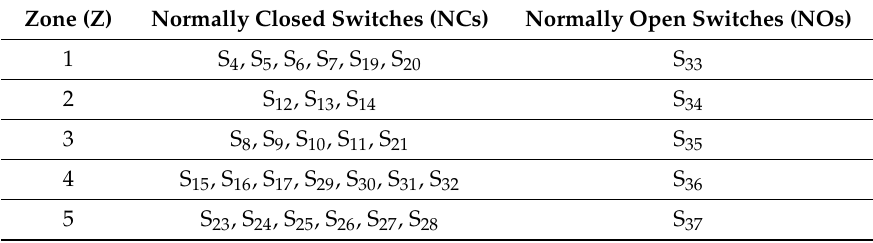
Table 2. Set of switches in each